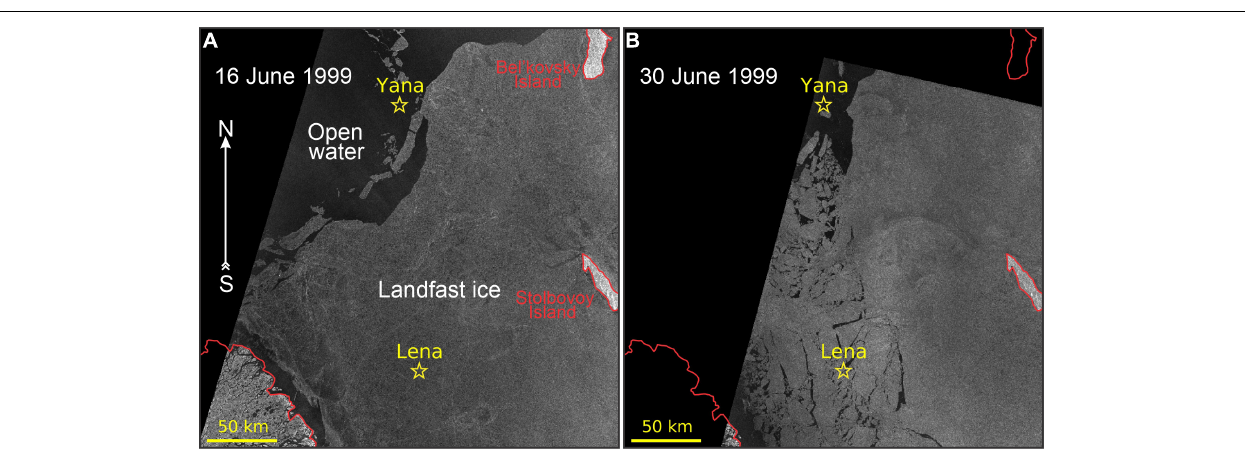
Frontiers in Marine Science |